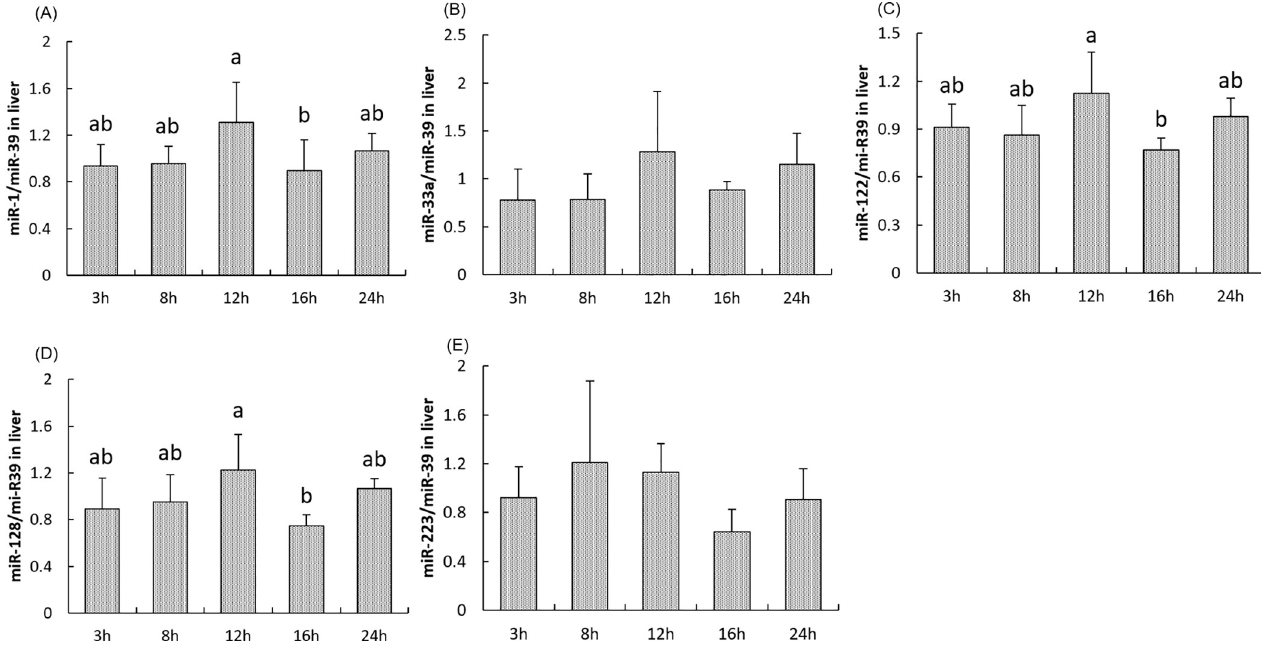
Fig 6. Postprandial expression of miRNAs involved in cholesterol metabolism miR-1(A), miR-33a (B), miR-122(C), miR-128(D), and miR-223(E) in the liver of rainbow trout at 3h, 8h, 12h, 16h and 24h after the meal. Indicated miR expression values were normalized to miR-39 levels. Values are means (n = 6), with their standard deviations represented by vertical bars. a, b Mean values with unlike letters were significantly different ( P < 0.05; One-way analysis of variance, Tukey’s test).